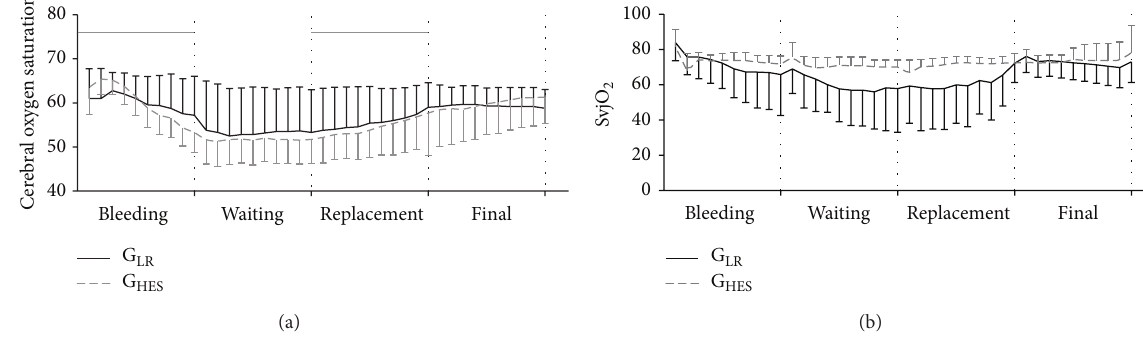
Figure 2: Cerebral oxygenation parameters during the four phases of the study: cerebral oxygen saturation (INVOS) (a) and SvjO 2 (%) (b). The two groups are shown: G LR —black line and G HES —dashed grey line.